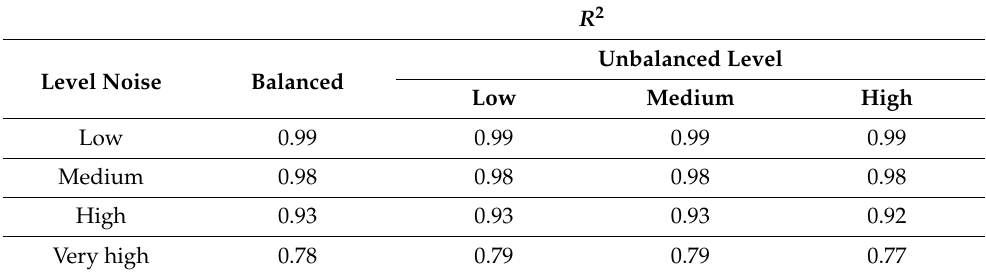
Table 16. Behavior of the R 2 adj statistic at different noise and unbalanced levels.